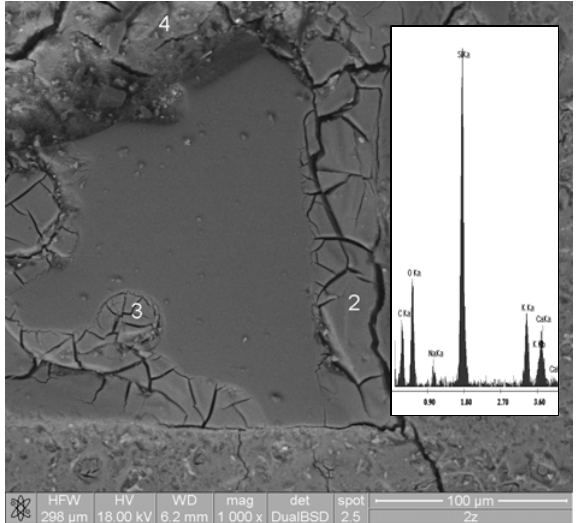
Fig 6. SEM image of potassium-sodium-calcium silica gel in the interface of opal grain